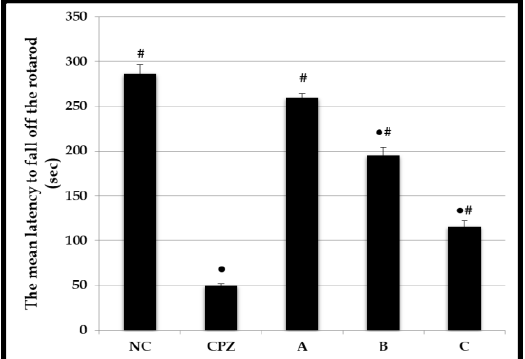
Figure 4. Effect of CPZ and A, B, and C formulae on motor coordination and balance in rats using accelerating rotarod. Values are expressed as mean ± SEM, n = 6 rats/ group. ● Significant change at p ≤ 0.05 with respect to negative control (NC) rats. # Significant change at p ≤ 0.05 with respect to CPZ-treated rats.